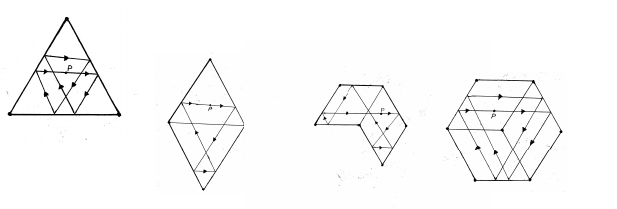
Figure 11. A periodic billiard motion in the equilateral triangle T = T 1,1,1 starting at P . First, extended by the reflection U to a periodic billiard motion in the quadrilateral Q = T ∪ U ( T ) . Second, extended by the relection S to a periodic billiard motion in Q ∪ S ( Q ) . Third, extended by the reflection SR to a periodic billiard motion in the stellated equilateral triangle H = K ∗